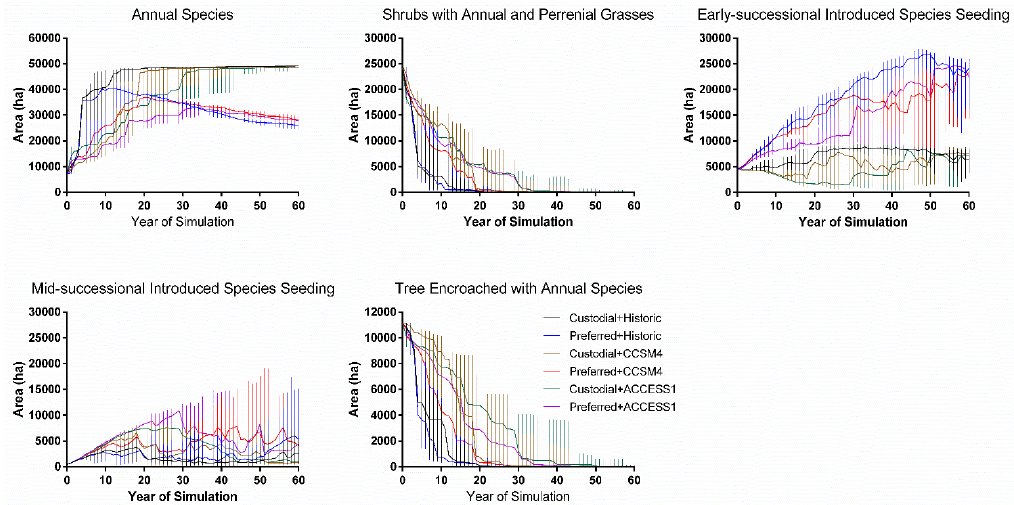
Figure 8. Median area (ha) of dominant treated and recipient classes of Wyoming big sagebrush–upland in the Black Mountains. Note the different y-axis scales. Error bars are 25% and 75% quartile range based on 10 Monte Carlo replicates.